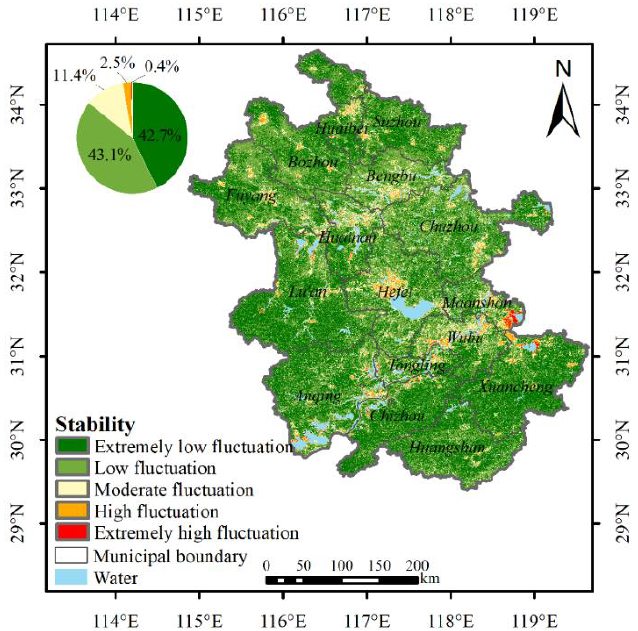
Figure 6. Stability of variations in EVI in Anhui Province during 2000 – 2020.